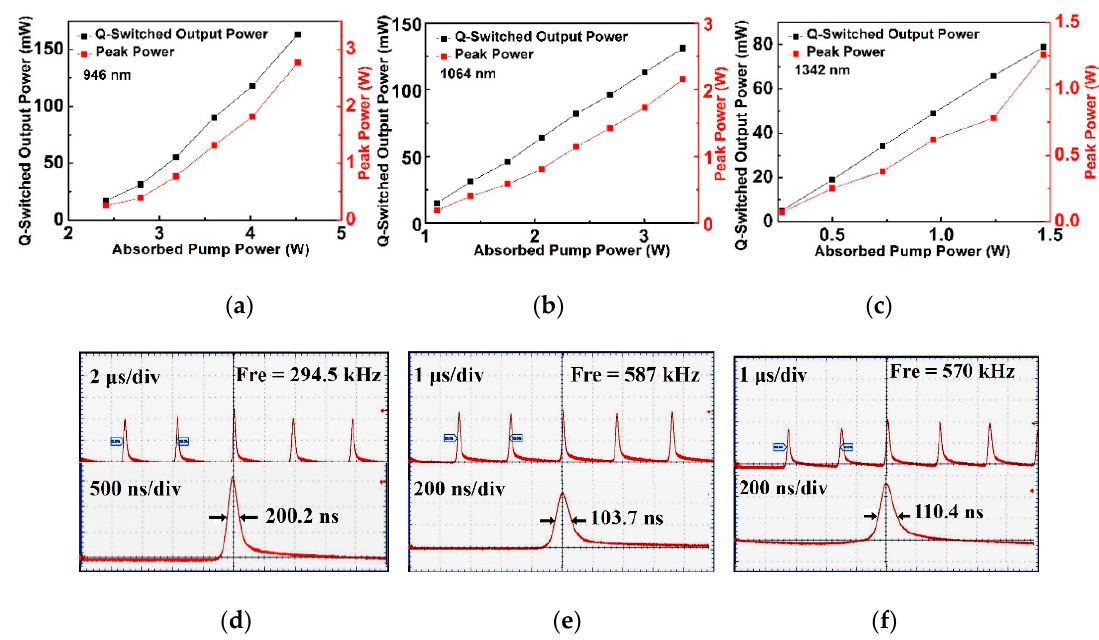
Figure 4. The detailed output characteristics of Si nanosheets based Q-switched lasers. ( a – c ) The maximum Q-switched average output power and highest peak power at 0.9, 1.06, and 1.3 µm, respectively. ( d – f ) The typical pulse trains at 0.9, 1.06, and 1.3 µm, respectively.